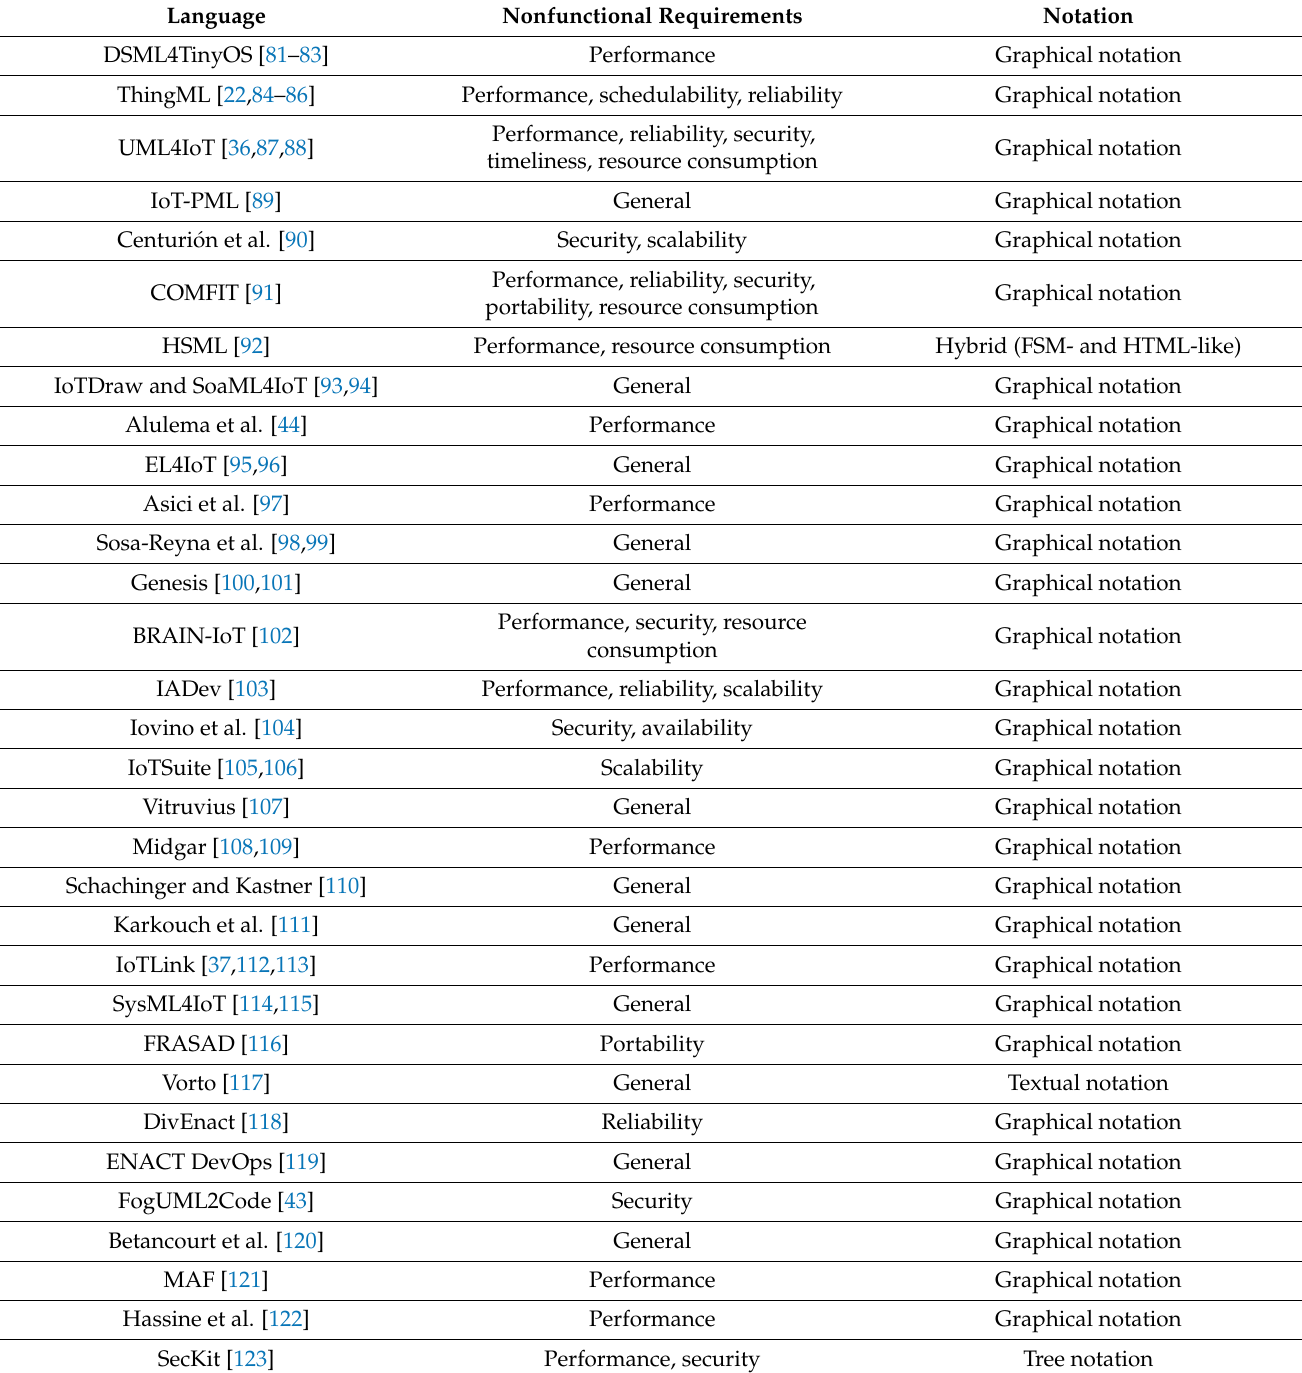
Table 2. The modeling languages for IoT that support the different types of nonfunctional properties and their notation set